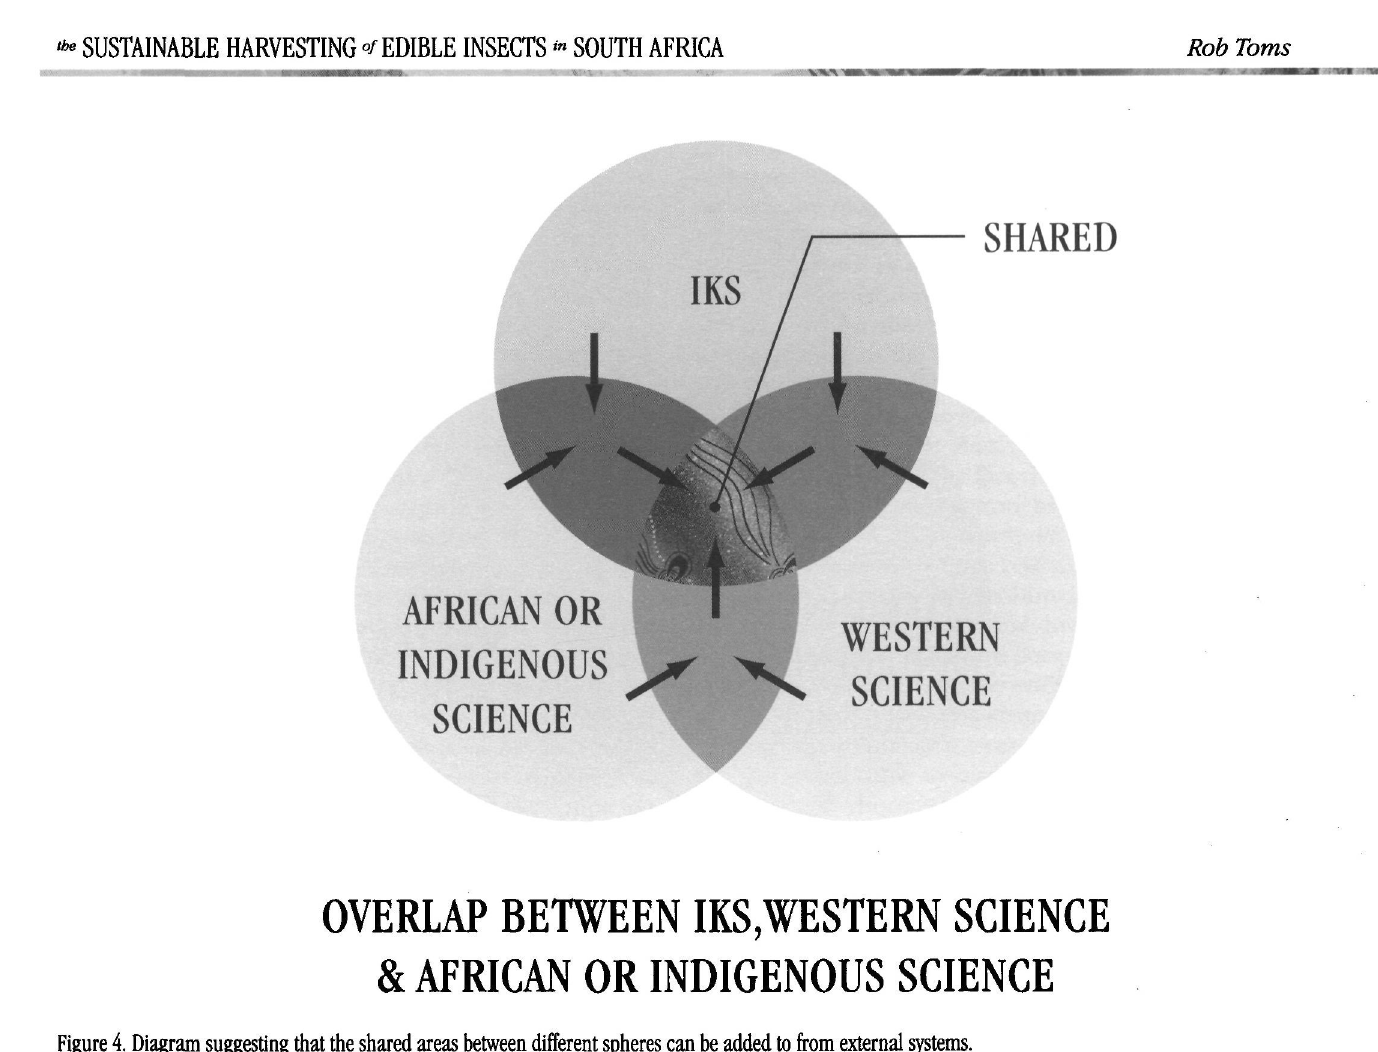
Figure 4. Diagram suggesting that the shared areas between different spheres can be added to from external